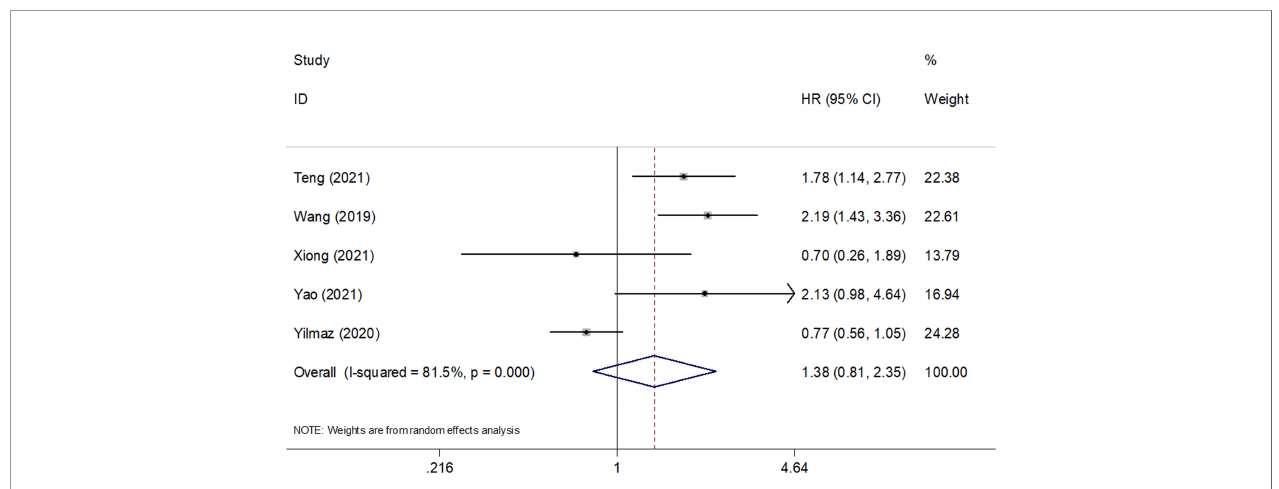
FIGURE 3 | Forest plots of pooled HRs and associated 95% CIs of the effect of high versus low SII for progression-free survival in patients with